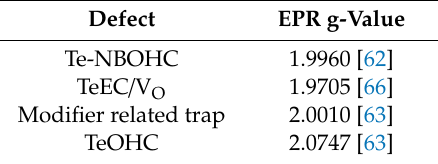
Table 1. Defects found in tellurite glasses and their EPR